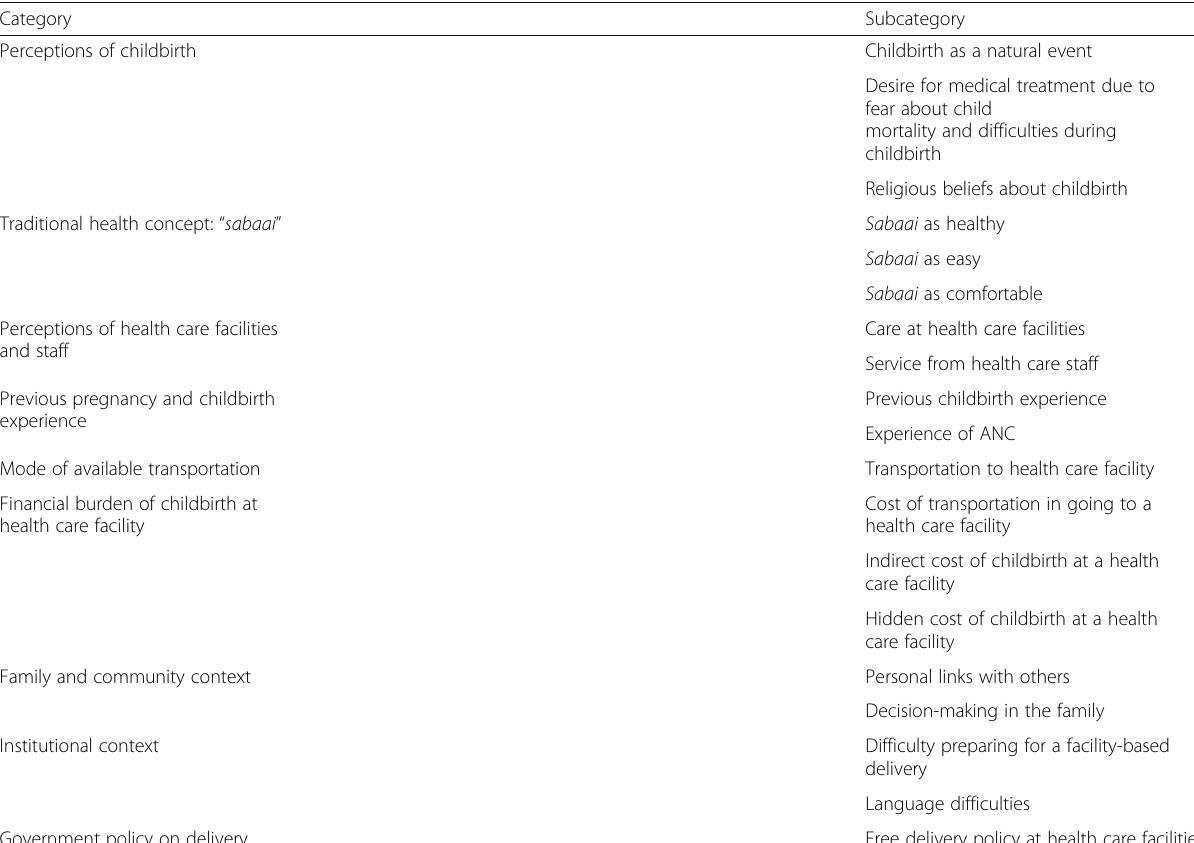
Table 2 Factors influencing choice of facility-based